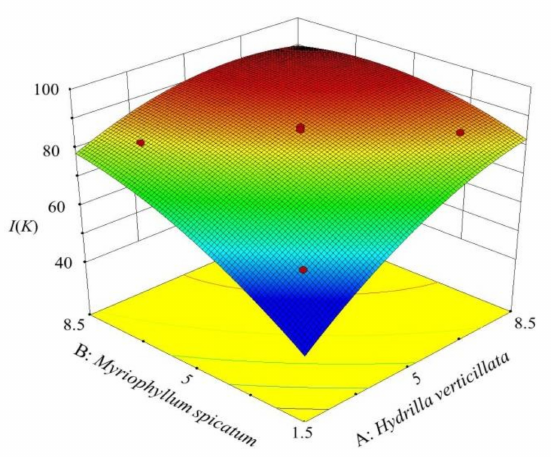
Figure 3. 3D surface graph of factors A and B and response variable I ( K